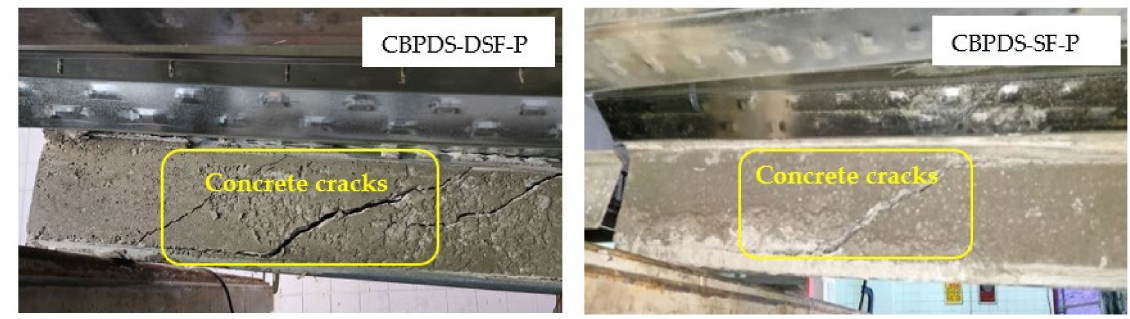
Figure 11. Typical concrete cracks failure inside the C-purlins beam.